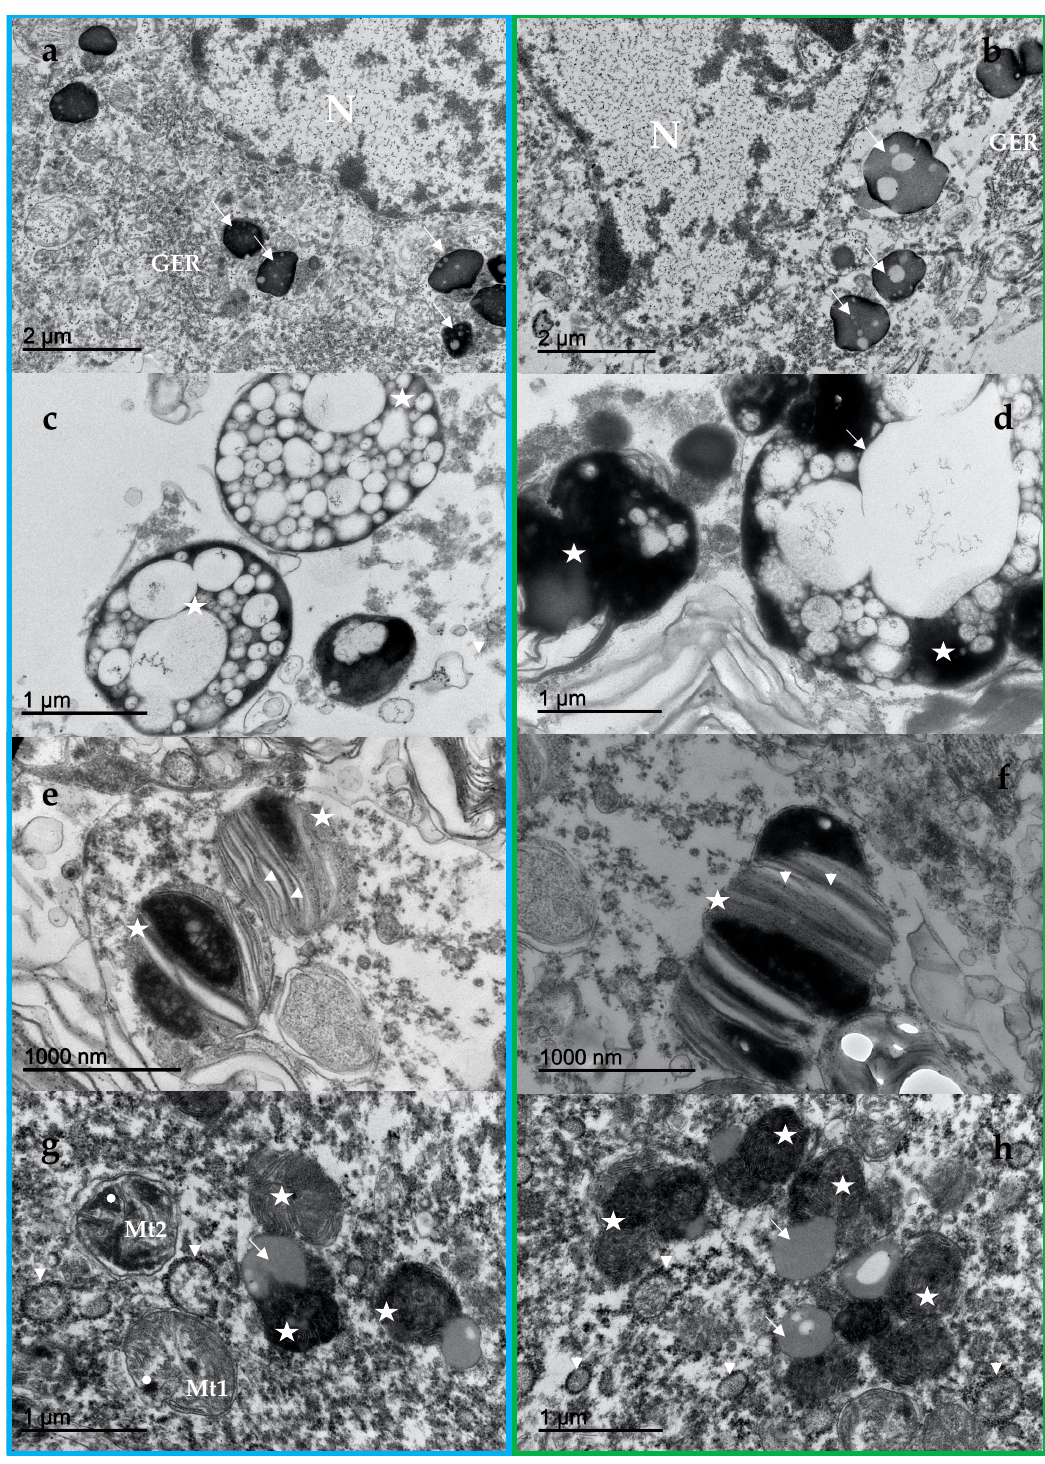
Figure 2. Ultrastructural analysis. ASD, blue box; BBW, green box. Ultrastructure of the neuromelanin via EM ( a – f ). Irregular round homogeneous electron-dense melanin granules distributed in dense granules (arrows) throughout the cytoplasm, in this case near the nucleus (N) and the granular endoplasmic reticulum (GER) ( a , b ). Numerous variable-sized electron-lucent lipids within